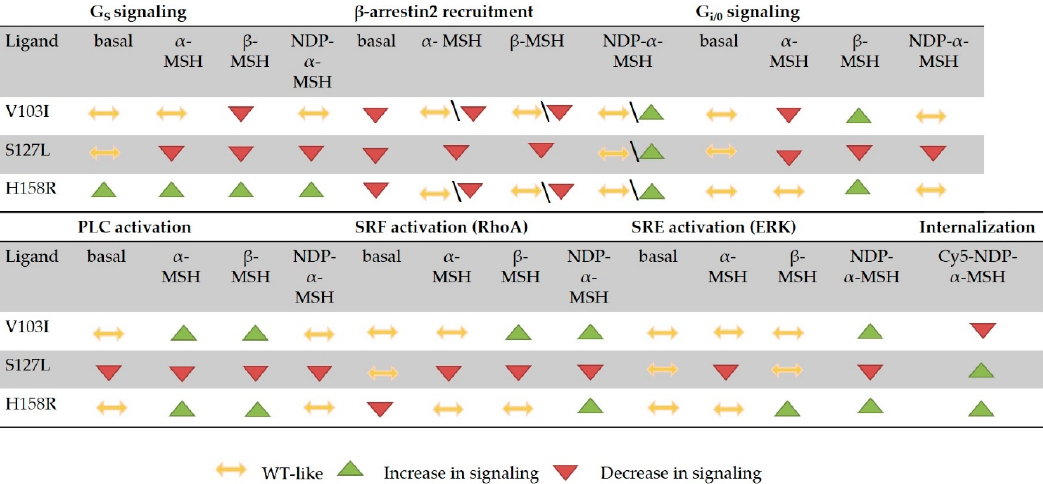
Figure 7. Summary of all functional data for the MC4R mutations V103I, S127L and H158R . This figure gives a crude overview of the differences in signaling profiles between the mutations, but also between the three tested ligands. Signaling is indicated as either decreased or increased when bias value deviated ≥ 0.5 bias values from the MC4R WT. For β -arrestin2 recruitment, the bias value differences were below 0.5, but statistically significant when analyzed with two-way ANOVA, followed by Dunnett’s post-hoc